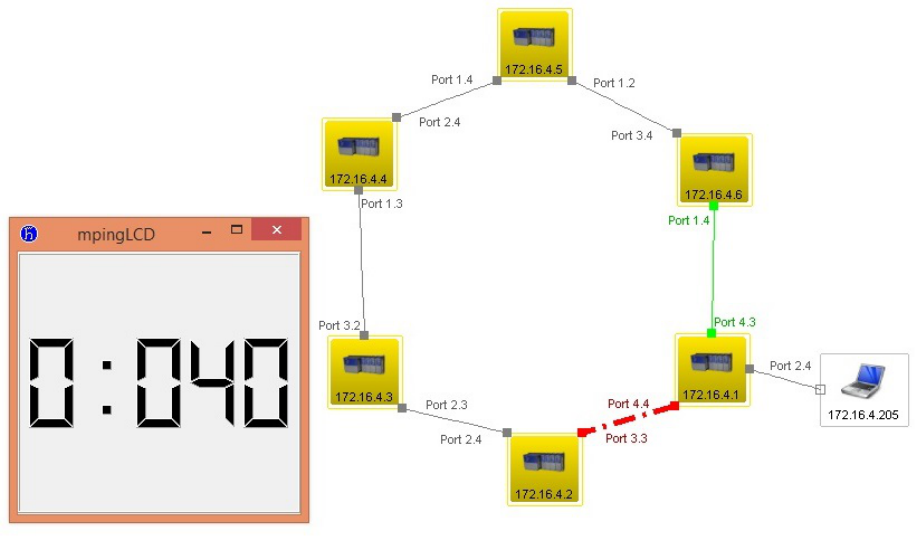
Figure 19. MRP ring network with one cable (link)